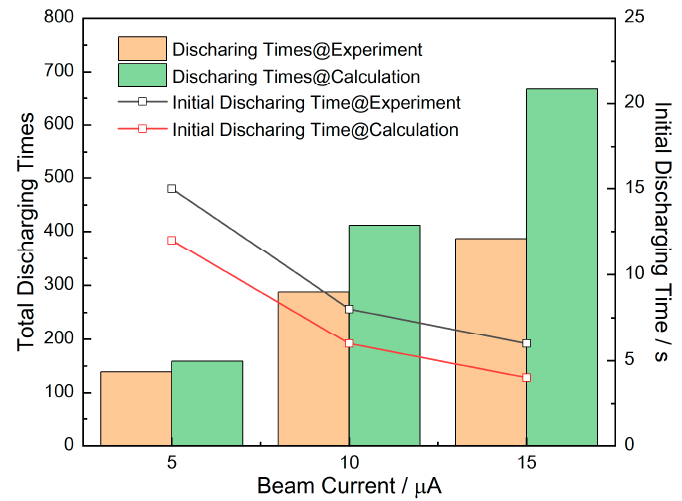
Figure 14. Comparison of experiment and simulation of discharging characteristics of PI within 20